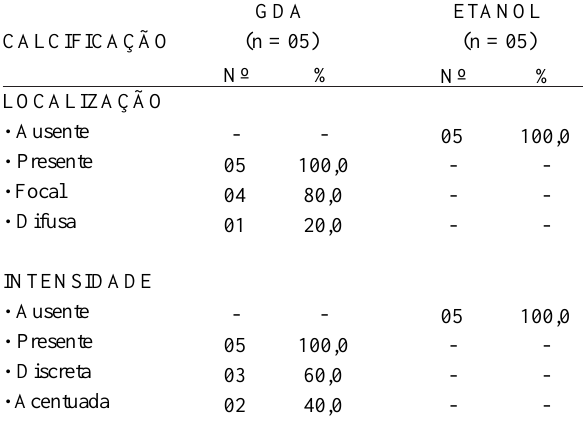
intensidade, nos grupos de